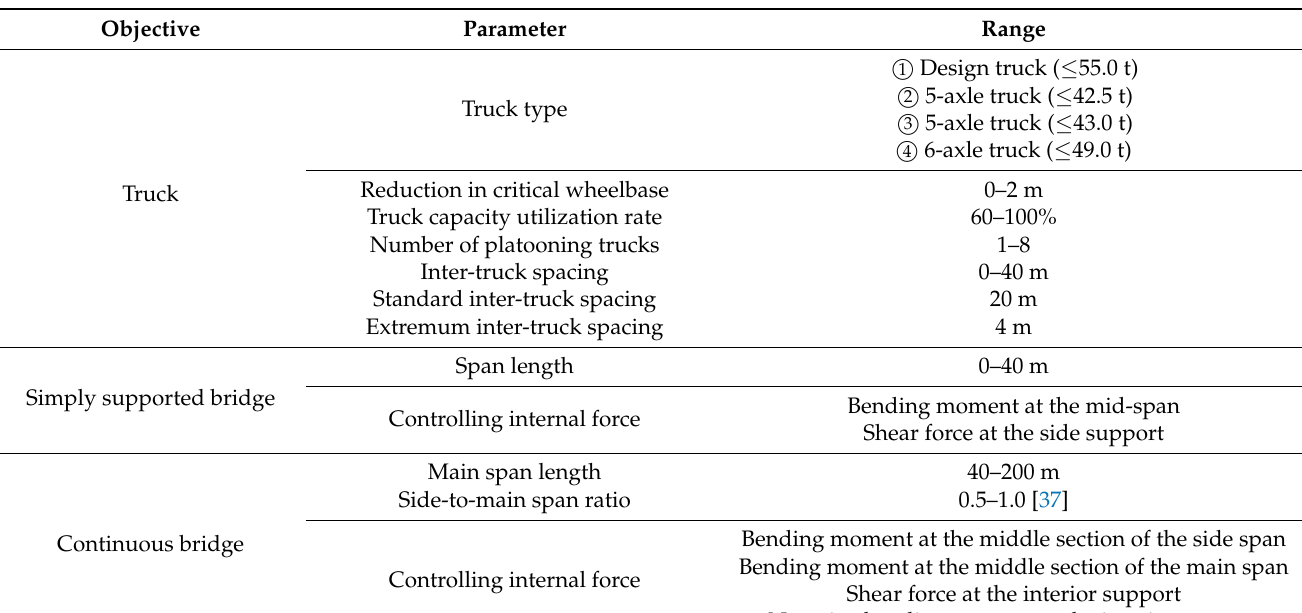
Table 1. Parameter setting for assessing load effects of highway bridges under ATP loads.